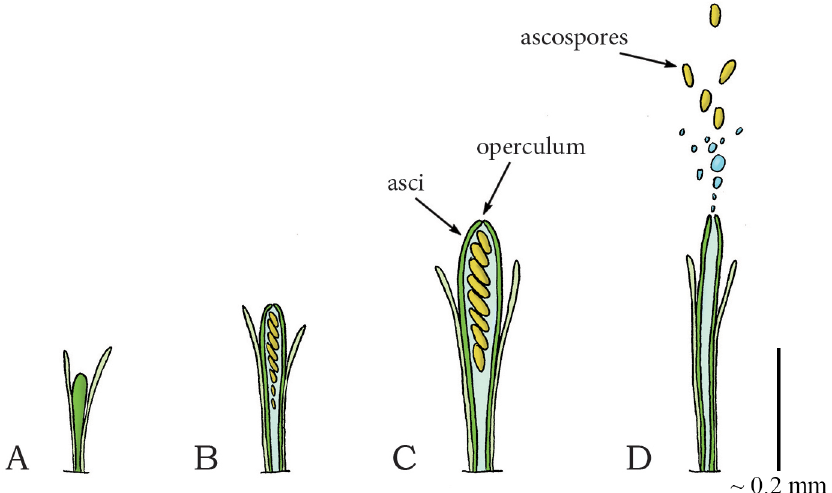
Fig 3. Fluid pressure catapult mechanism in the phylum Ascomycota (species Ascobolus immersus ). (A) Early stage of ascus development in Ascomycota. (B) Developed ascus containing the ascospores. (C) Osmotic water absorption increases turgor pressure and drives the expansion of the ascus. (D) When a critical pressure is reached (range: 0.30 – 1.54 MPa), the operculum breaks open, allowing contraction of the expanded wall, which drives the discharge of the ascospores together with the cell sap from the ascus. Drawings based on schematic drawings in [50]. Scale bar 0.2 mm (200 μ